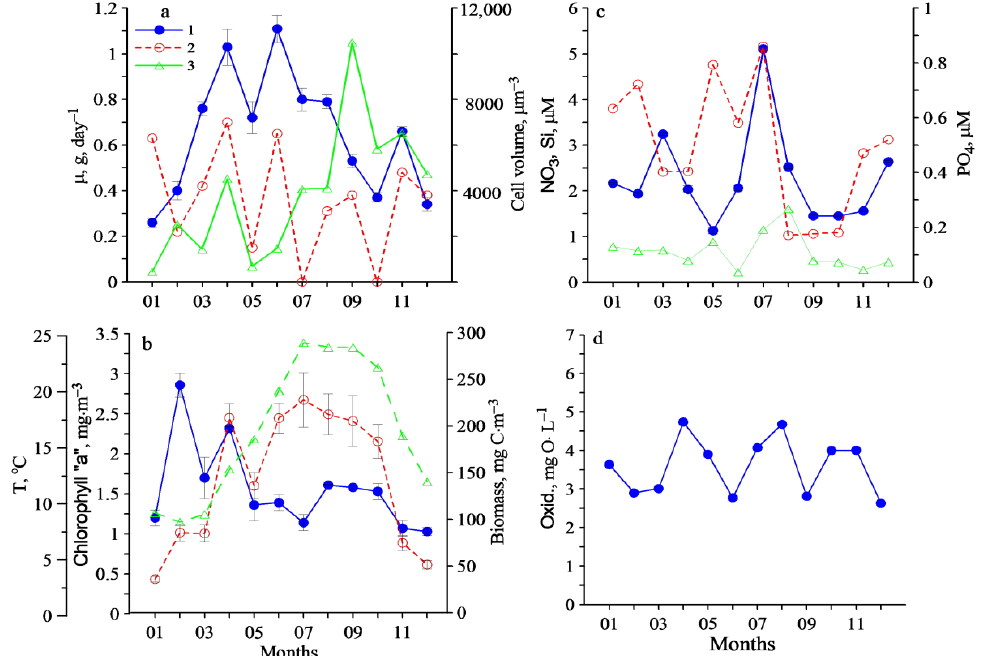
Figure 2. Seasonal variability: ( a ) phytoplankton growth rate (1), microzooplankton grazing (2) and average phytoplankton cell volume (3); ( b ) chlorophyll a concentration (1), phytoplankton biomass (2), water temperature (3); ( c ) nitrate (1), silicate (2), phosphate (3); ( d ) the permanganate oxidizability (1) in Station 1.